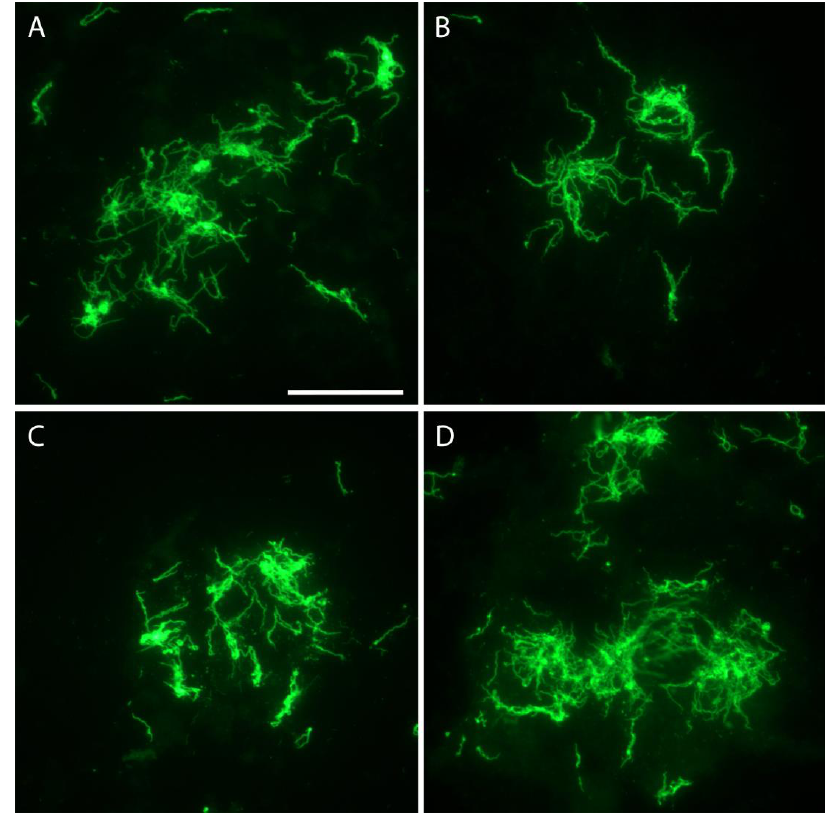
Figure 3. Borrelia hemsii aggregates in four eggs (Panels A – D ) from O. hermsi female F-1F (Table 5) stained with anti- B. hermsii rabbit hyperimmune serum and goat anti-rabbit FITC. Scale bar = 40 µm.